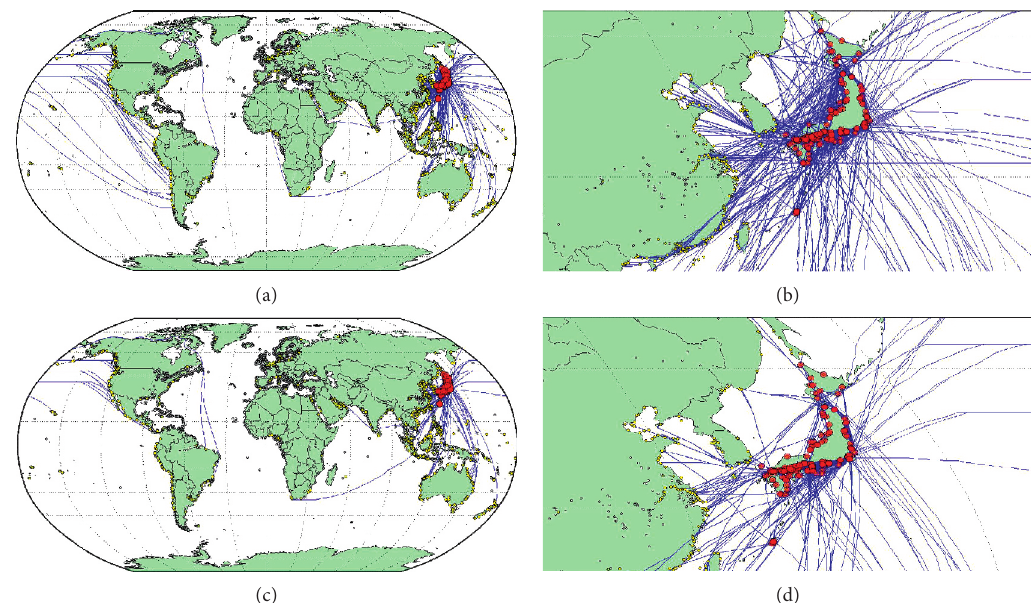
Figure 5: One-jump connections from Japanese ports to the world. (a) Global view (all). (b) Regional view (all). (c) Global view (top 2000). (d) Regional view (top 2000).